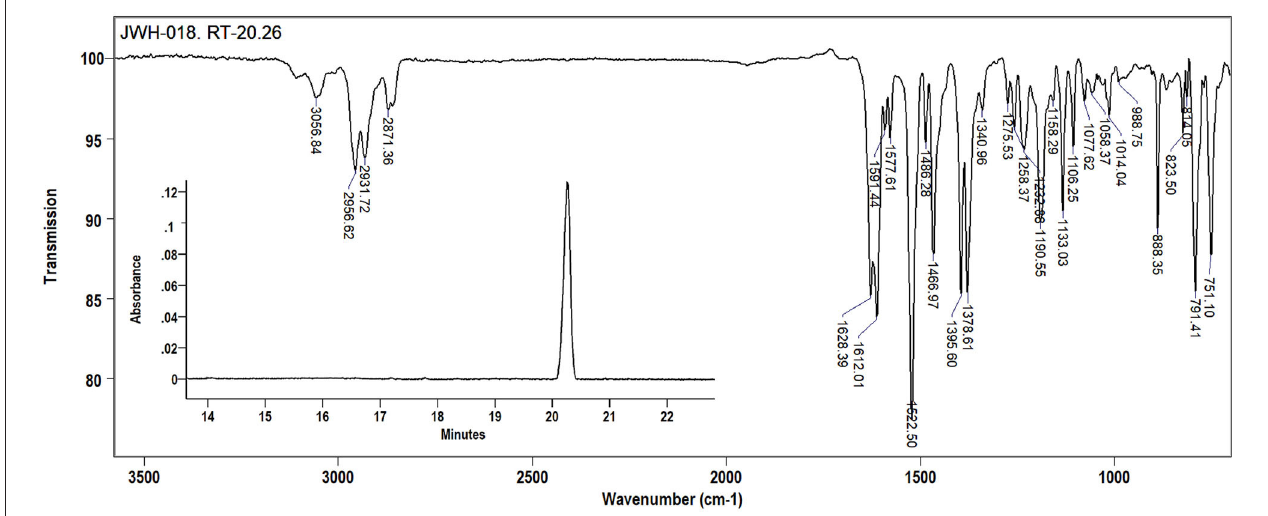
FIGURE 1 | Solid-phase mid-IR spectrum for JWH-018 (1-naphthalenyl(1-pentyl-1H-indol-3-yl)-methanone) at 4 cm − 1 resolution. Inset: the Grams-Schimdt reconstructed GC-FTIR chromatogram (SLB-5ms, 30m L × 0.25mm i.d., 0.25 µ m d f ).